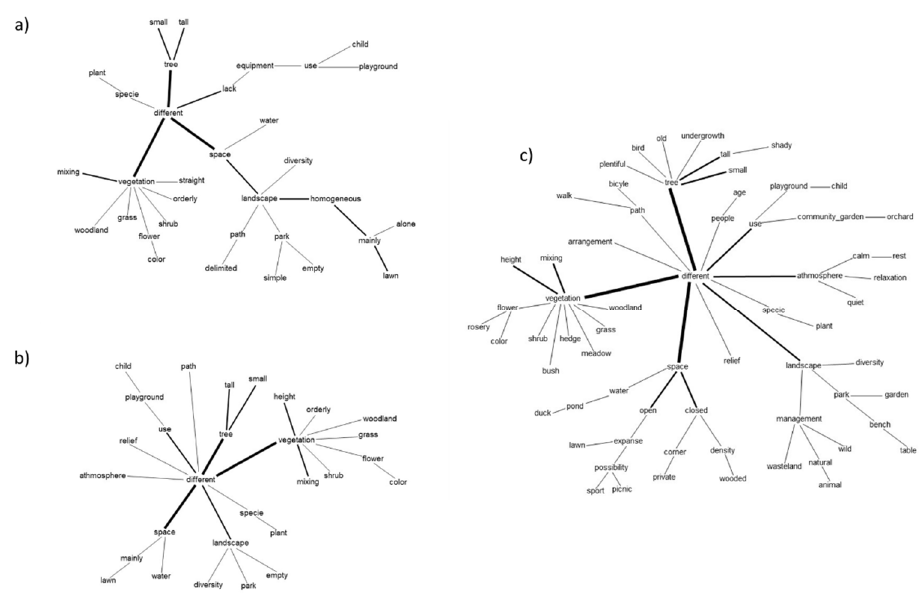
Figure 3. Visual maps of the most frequent associations made by visitors between the words listed in the different word-clouds. Visual maps are named, respectively, ( a ), ( b ) and ( c ) for the word-cloud ( a – c ), respectively. The thicker the edges, the more sentences the words were associated in. Word-clouds a, b and c refer to Figure 2.